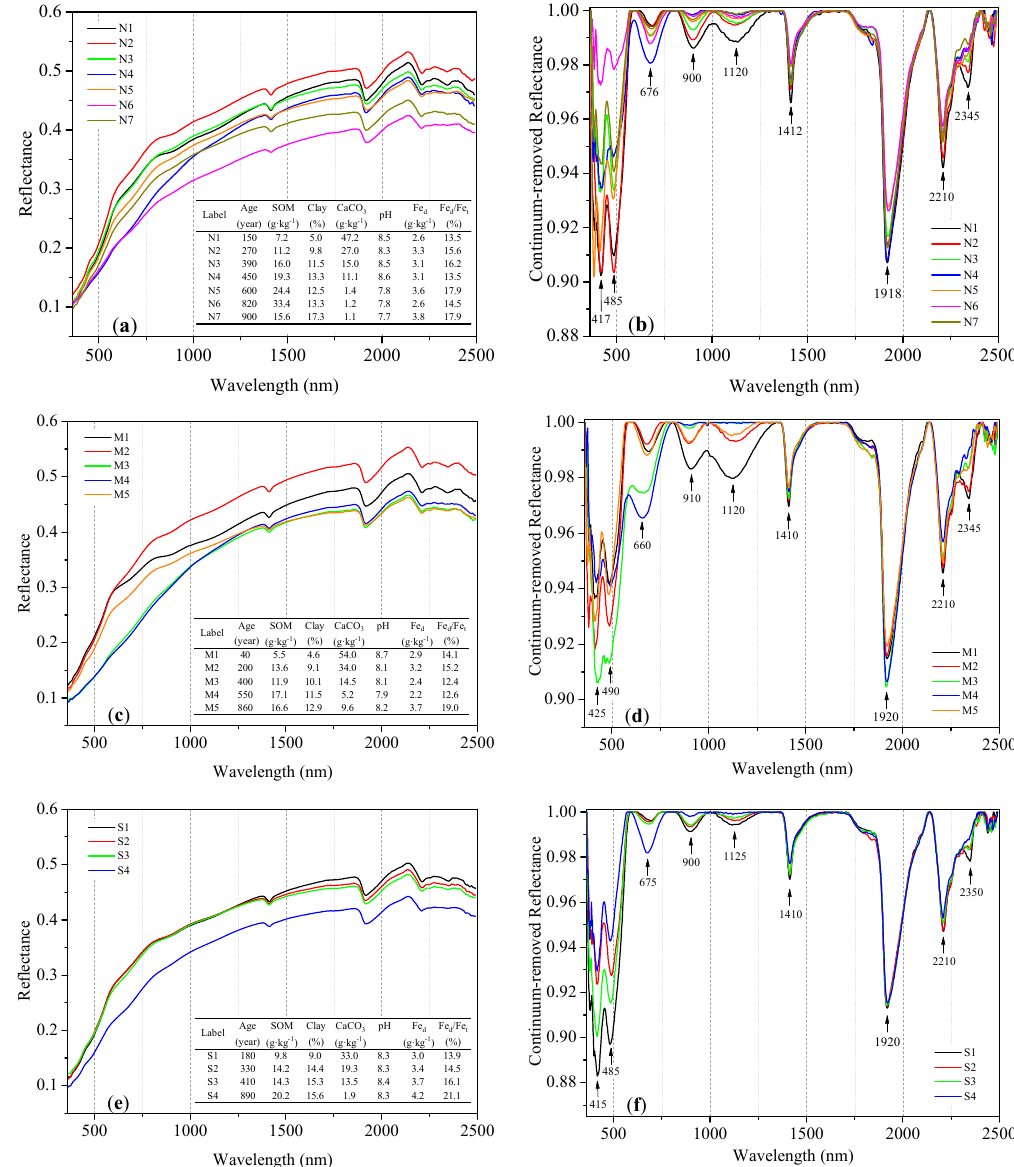
Figure 7. Original and continuum-removed spectra of topsoil samples (0–5 cm): ( a ), ( c ), ( e ): original spectra of topsoil samples for north line, middle line and south line, respectively; ( b ), ( d ), ( f ): continuum-removed spectra of topsoil samples for north line, middle line and south line, respectively. The overall changes in the reflectance intensity of original spectra primarily showed SOM accumulation with age. The changes in the absorption depth at 2341 nm revealed the CaCO 3 leaching process with age. The absorption features around 420, 485, 670 and 900 nm in continuum-removed spectra showed the difference in goethite content.